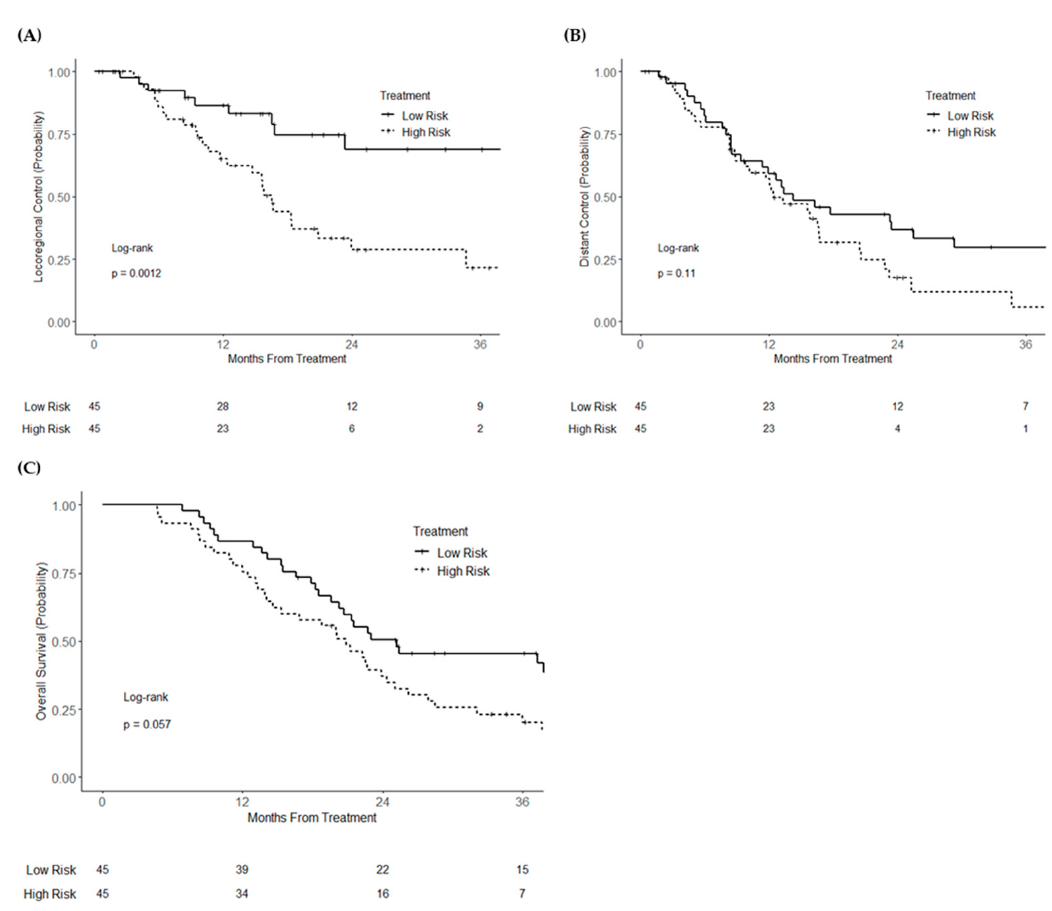
Figure 1. Kaplan–Meier curves of ( A ) locoregional recurrence, ( B ) distant recurrence, and ( C ) overall survival of the training cohort of resectable pancreatic cancer patients, stratified by risk score